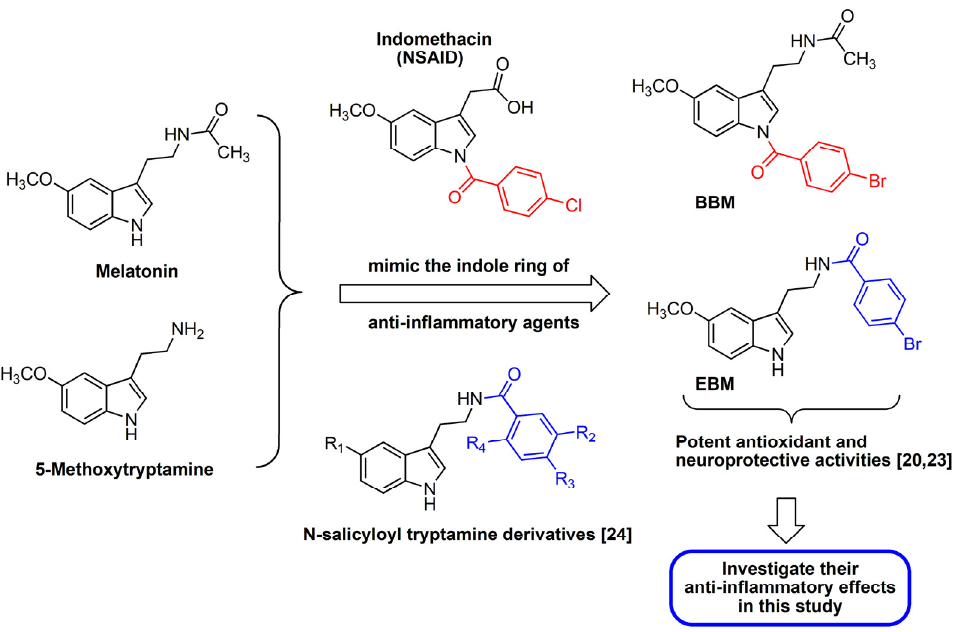
Figure 1. Design of the target compounds; BBM and EBM.